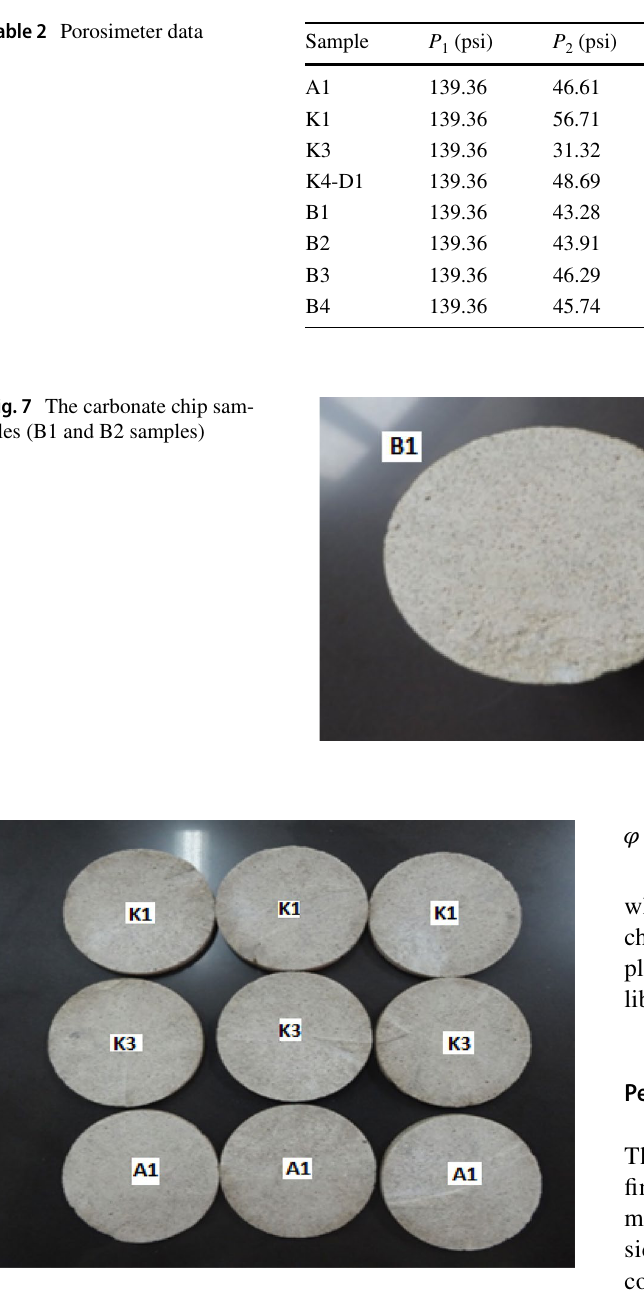
Fig. 8 Selected carbonate chips (K1, K3 and A1 samples) for BET